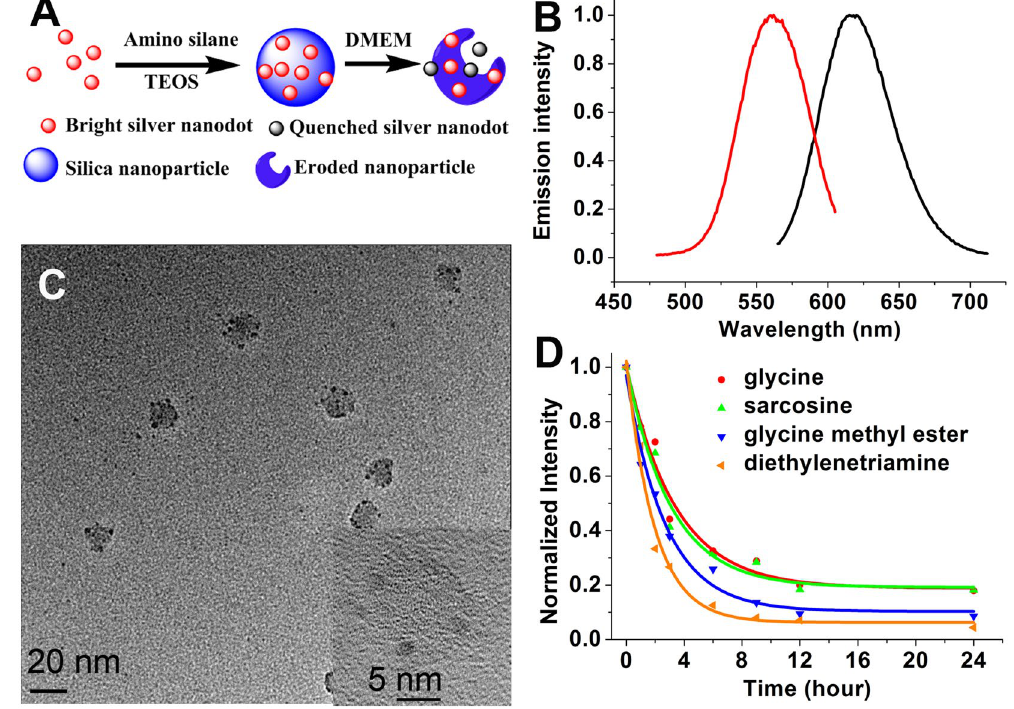
Figure 5. Detection of silica degradation with luminescent silver nanodots. ( A ) Schematic showing the encapsulation of silver nanodots in silica nanoparticles and their optical detection of silica degradation. ( B ) Emission (black) and excitation (red) spectra of the 615-emitter. ( C ) TEM image of silver nanodot- encapsulating silica nanoparticles (AgND@SiO 2 ). Scale bar, 20 nm. Inset showing a high resolution image of the above nanoparticles. Scale bar, 5 nm. ( D ) Normalized luminescence intensity decay of the above AgND@SiO 2 in the presence of glycine (red), sarcosine (green), glycine methyl ester (blue) and diethylenetriamine